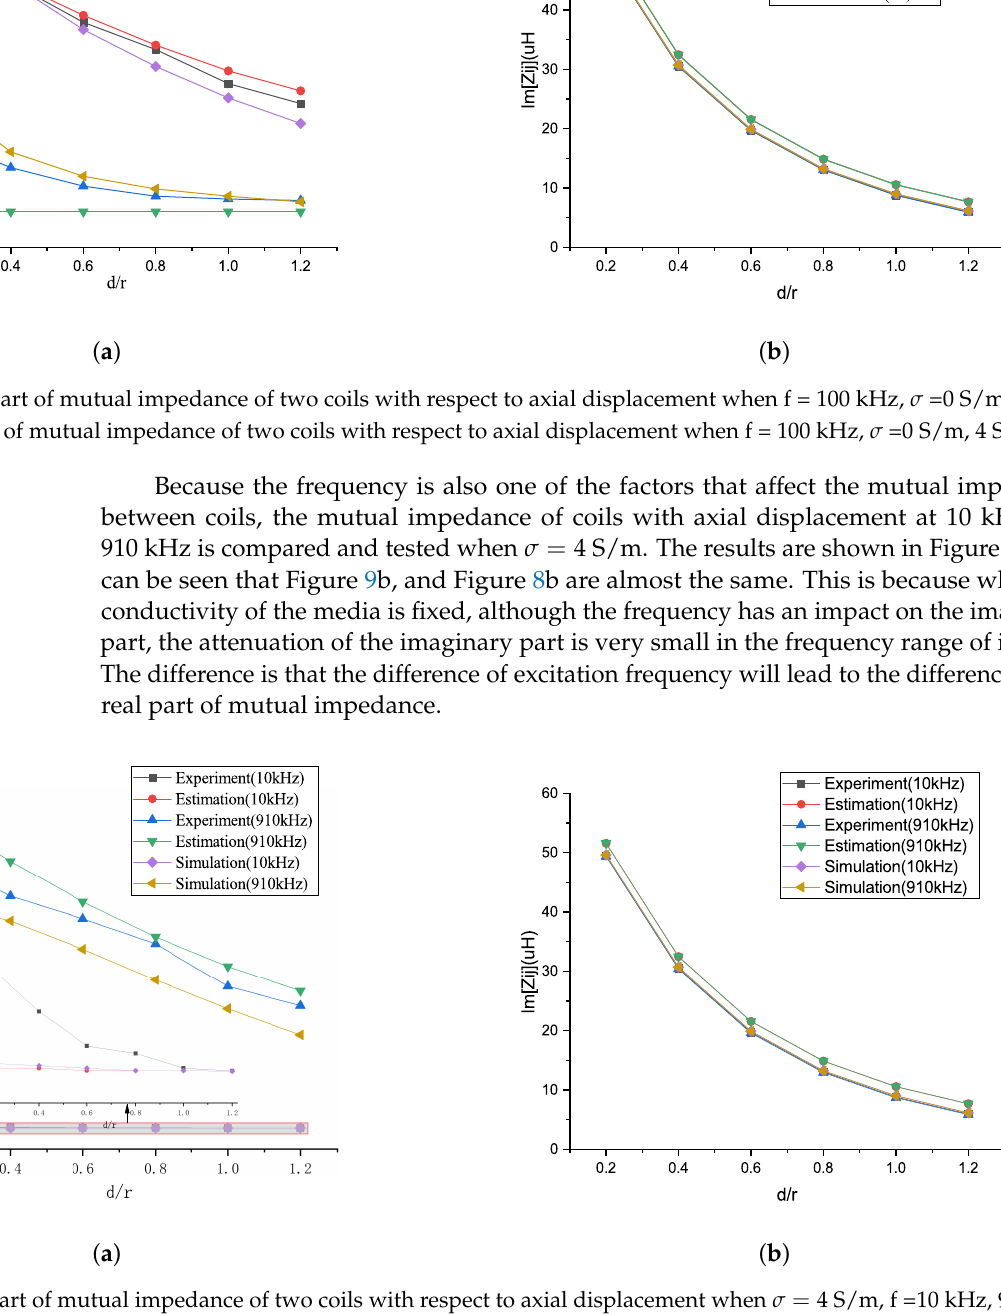
Figure 9. ( a ) The real part of mutual impedance of two coils with respect to axial displacement when σ = 4 S/m, f =10 kHz, 910 kHz. ( b ) The imaginary part of mutual impedance of two coils with respect to axial displacement when σ = 4 S/m, f = 10 kHz, 910